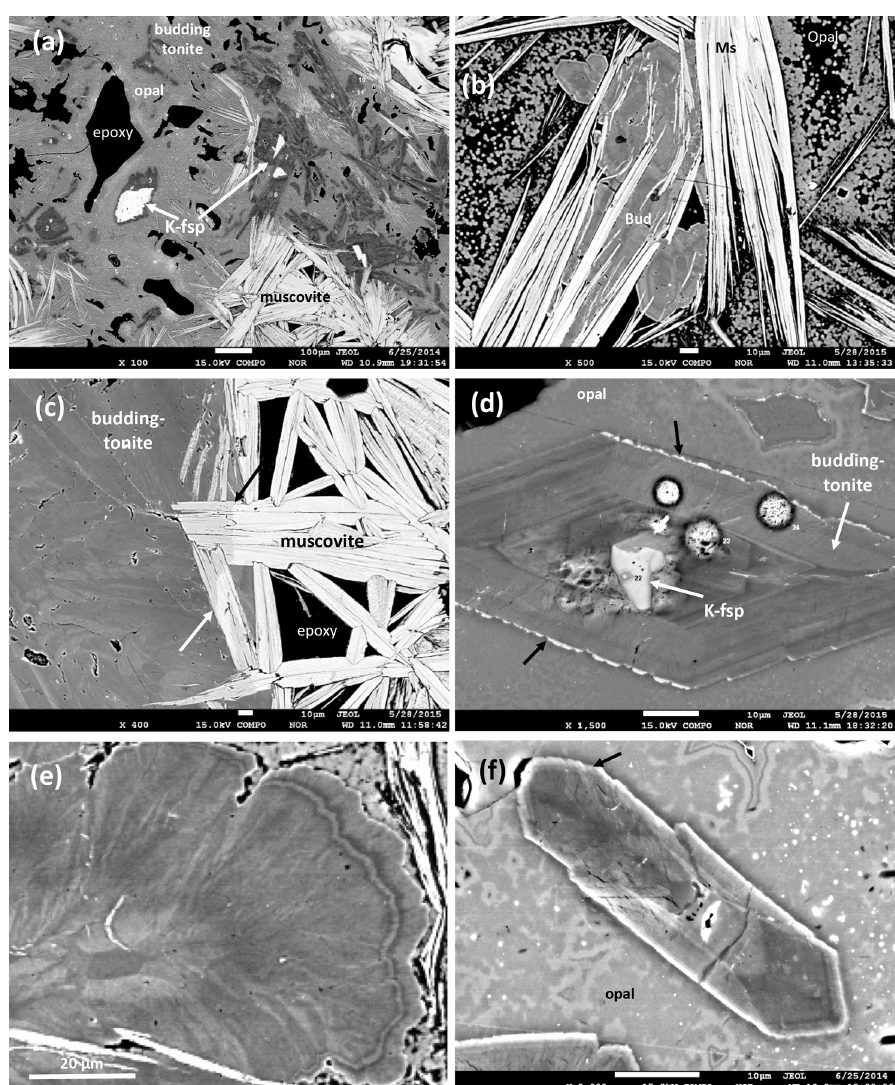
Figure 5. BSE images of the buddingtonite–muscovite assemblage. (a, b) Overview: lath-shaped crystals with white BSE contrast are muscovite, buddingtonite is dark gray, and opal is light gray. White crystals within buddingtonite are relict, igneous K-feldspar. Note large pore space, filled by epoxy. (c) Contact of muscovite to buddingtonite; arrows point to change in BSE contrast in muscovite, indicating a significant tobelite component. (d) Buddingtonite with sector zoning and relict K-feldspar in opal matrix. Black arrows point to enrichment of the K-feldspar component in the outermost rim. White, round dots are areas of beam damage due to analysis. (e) Outer part of an oscillatory zoned buddingtonite crystal; darker areas are rich in N and H 2 O. Note fibrous character with individual fibers ≤ 1µm. (f) Sector zoned crystal, approximately 10µm wide, with < 1µm outgrowths at its tip (arrow). Small numbers in (a) and (d) refer to analyses published in Franz et al.